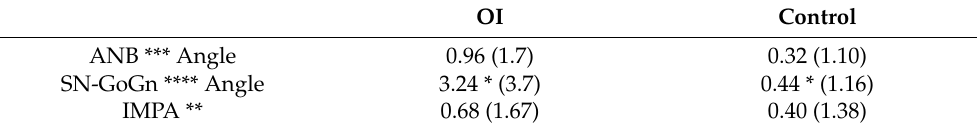
Table 3. Analysis of the cephalometric results in the subgroup sample. Osteogenesis Imperfecta (OI). OI